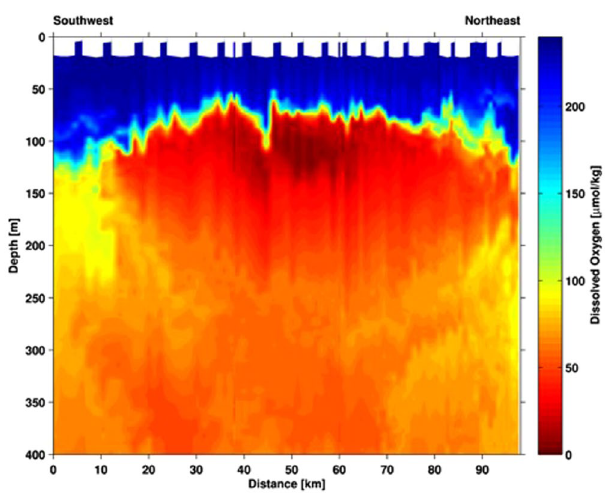
Figure 3. Dissolved oxygen concentrations as measured during the IFM13 glider survey on April 7 th ,